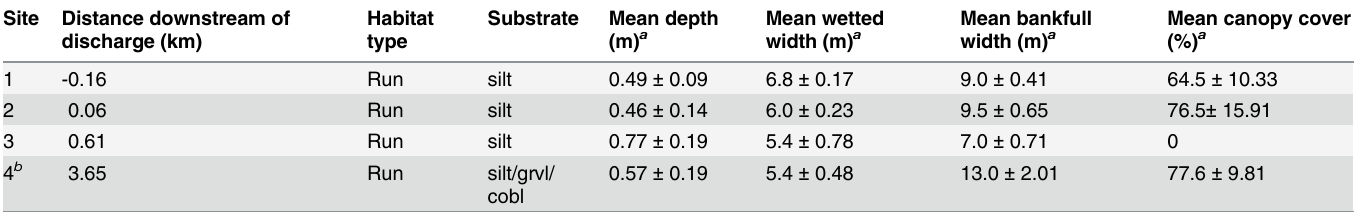
Table 4. Physical measurements and description of sites used in